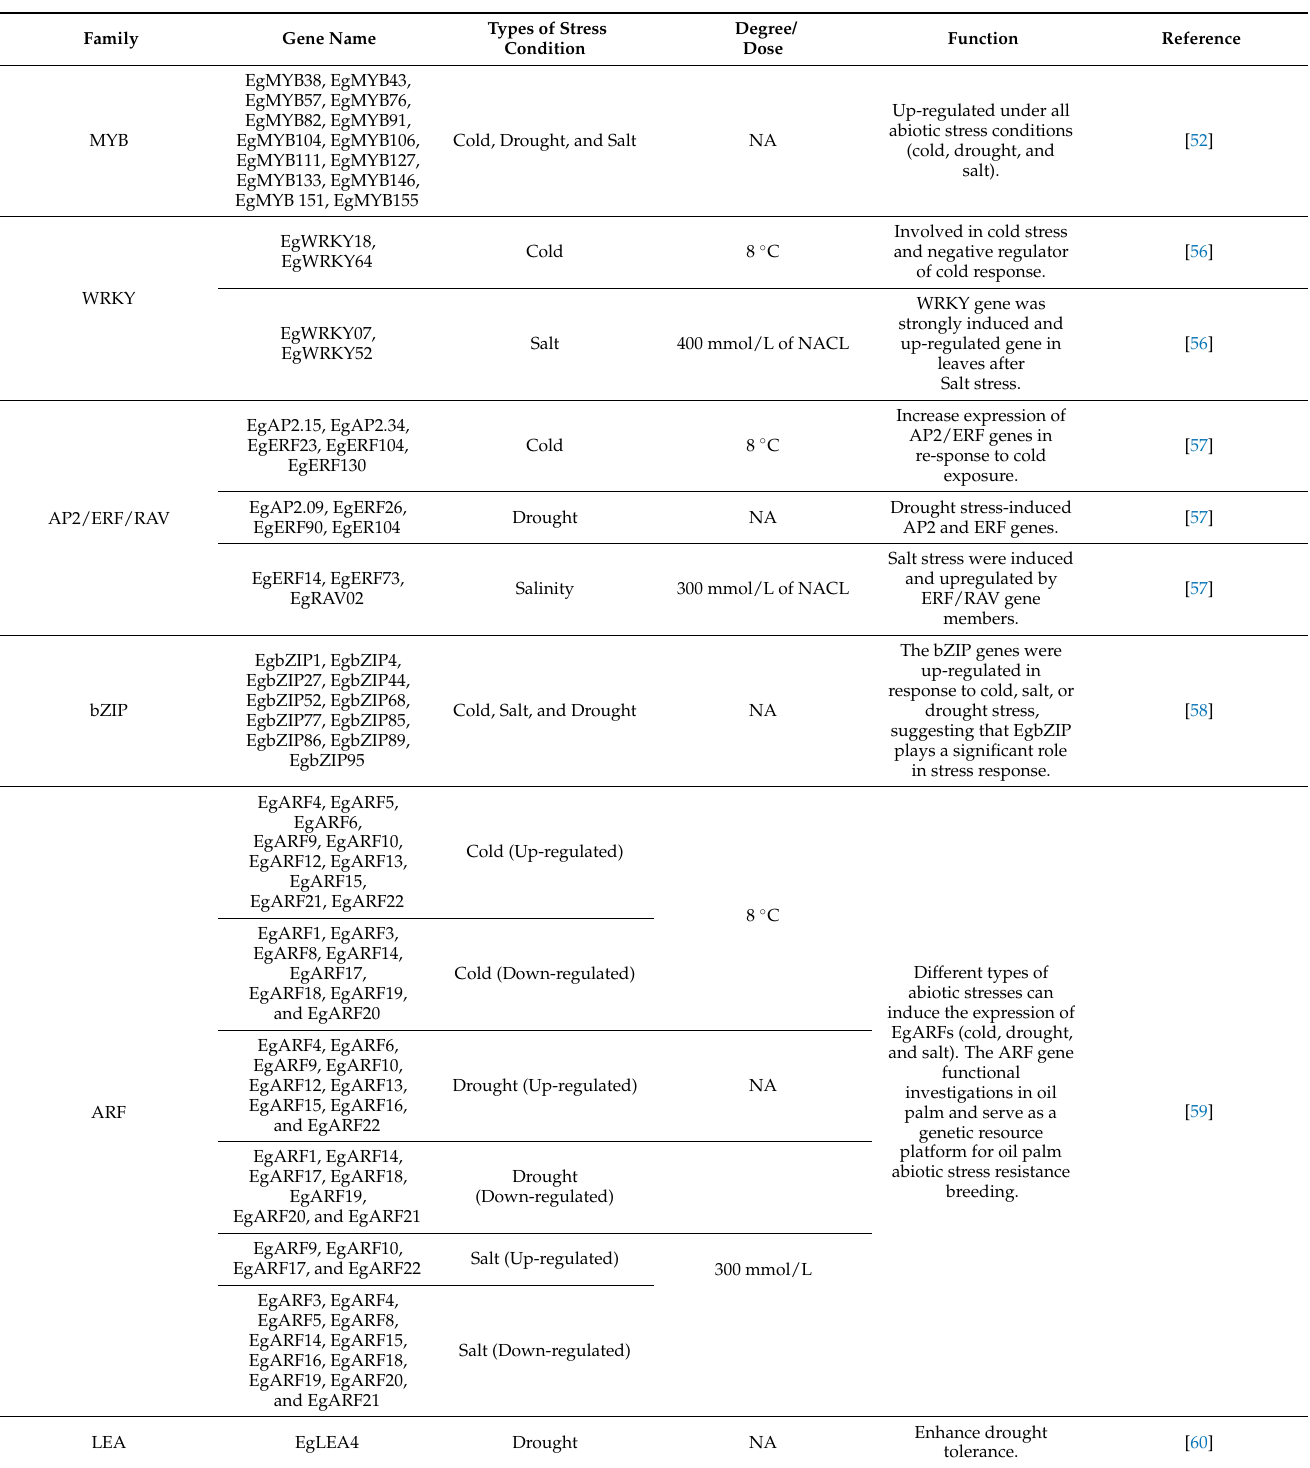
Table 1. Summary of Abiotic stress-related genes in oil palm under different types of stress conditions. Family Gene Name Types of Stress Condition Function